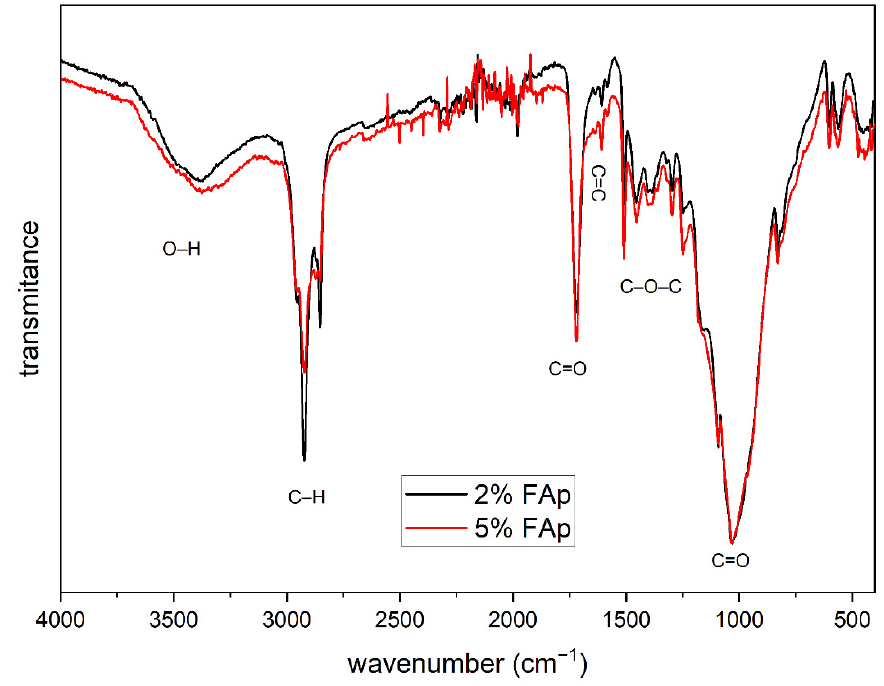
Figure 2. FTIR spectra of polymers with different content of FAp. The SEM micrographs of pure i-FLOW and polymer with 2 and 5%FAp are